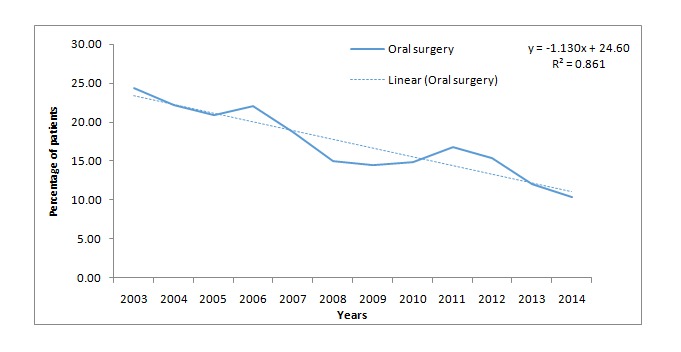
Graph 3: Trend line showing variation of referrals to oral surgery department.